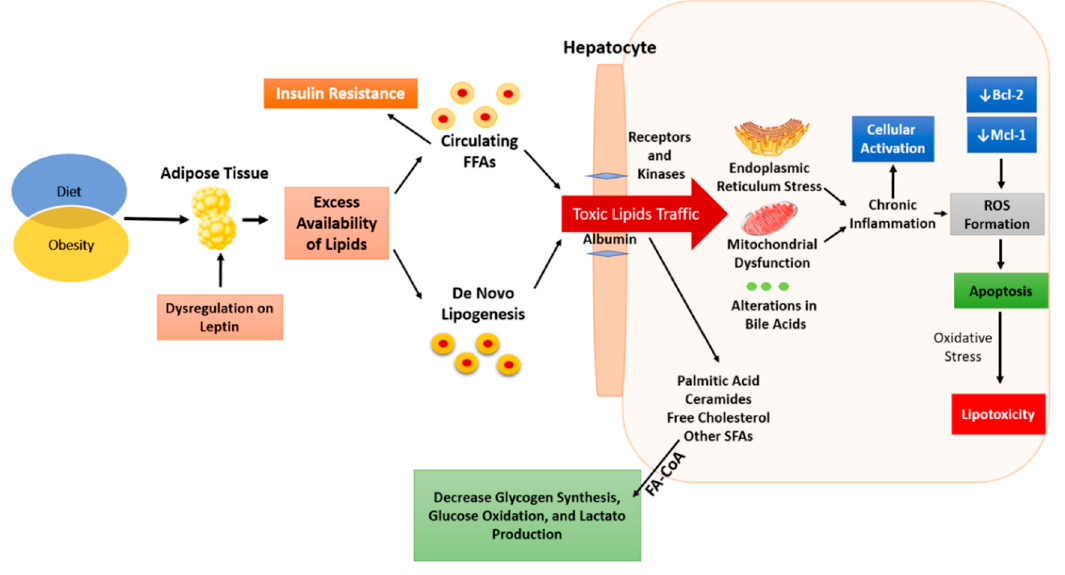
Figure 2. The increment in dietary energy availability and sedentary lifestyles leads to obesity. Obesity causes an excessive accumulation of lipids in the adipose tissue and in non-adipose tissue. Adipocytes provide a place to load and store energy in the form of triglycerides, protecting non-adipose tissues from immoderate accumulation of lipids because they have a restricted capacity to store triglycerides. This protection needs the permissive action of leptin, a hormone that decreases lipogenesis and increases oxidation in non-adipose tissue during acute overnutrition, dissipating the unnecessary energy of FFAs. The immoderate accumulation of FFAs exceeds the oxidative capacity of non-adipose tissues, thus potentiating the metabolic flux of fatty to other noxious non-oxidative pathways producing specially ceramides. The increment in FFAs increases tumor necrosis factor (TNF)- α , which promotes insulin resistance, and ROS, which trigger hepatocyte apoptosis. Also, SFAs induce endoplasmic reticulum stress, which leads to the upregulation of the pro-apoptotic BH3-only proteins (BIM and PUMA), resulting in inactivation of the antiapoptotic Bcl-2 family members (Mcl-1 and Bcl-xL). SFAs: saturated fatty acids, ROS: reactive oxygen species, FA-CoA: Fatty-acyl-CoA synthase, FFAs: free fatty